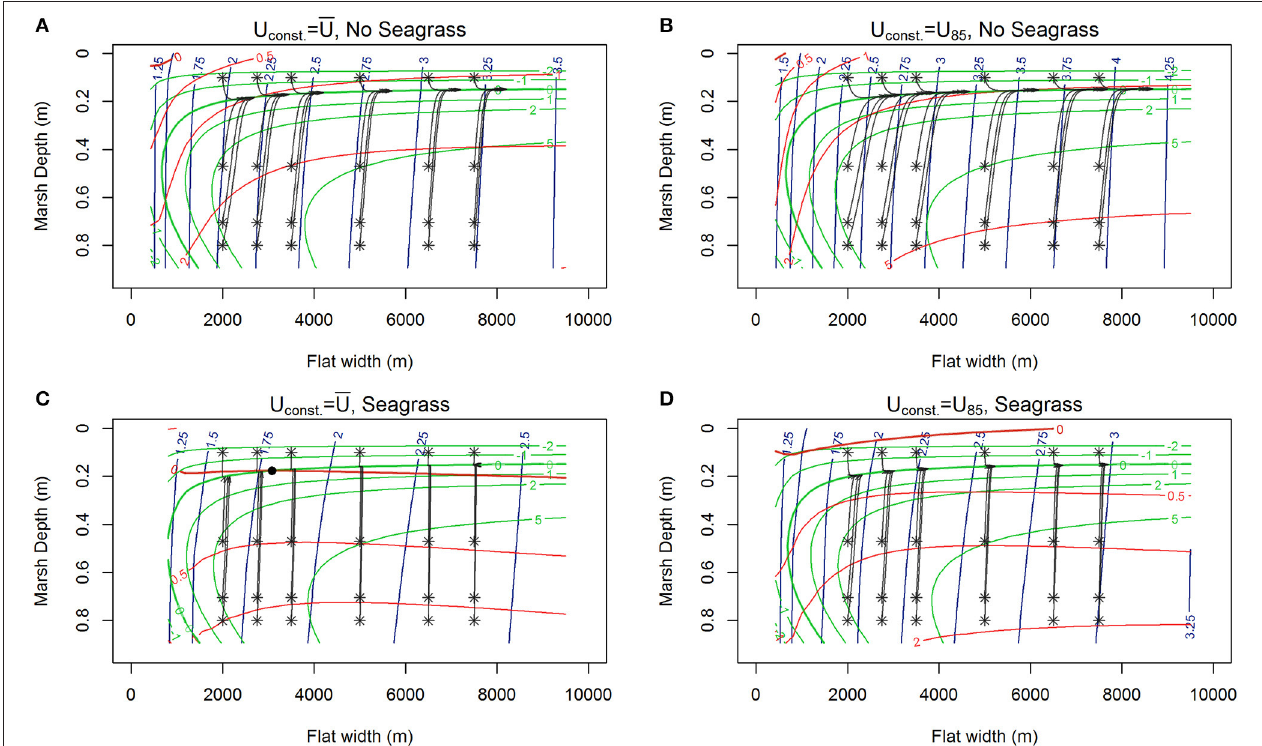
FIGURE 4 | Contours of lateral rates of change in tidal flat width (red), and vertical changes in marsh depth (green) from MHW alongside 1,000 year trajectories (black) of the system initiated at various tidal flat widths and marsh depths along the tidal flat depth nullcline surface (blue contours) for various wind conditions, RSLR = 4mm year − 1 , Co = 30 mg/L. (A) Erosion, no seagrass, marshes maintaining pace with RSLR ( U const = U = 6.87m s − 1 ). (B) Faster erosion, no seagrass, marshes maintaining pace with RSLR (U 85 = 8.5m s − 1 ). (C) Appearance of stable equilibria ( C , black dot) in the presence of seagrass at around 3km wide tidal flat, marshes maintaining pace with RSLR ( U const = U = 6.87m s − 1 , N = 250 shoots m − 2 ). (D) Slow erosion in the presence of seagrass, with marshes maintaining pace with RSLR (U 85 = 8.5m s − 1 , N = 250 shoots m − 2